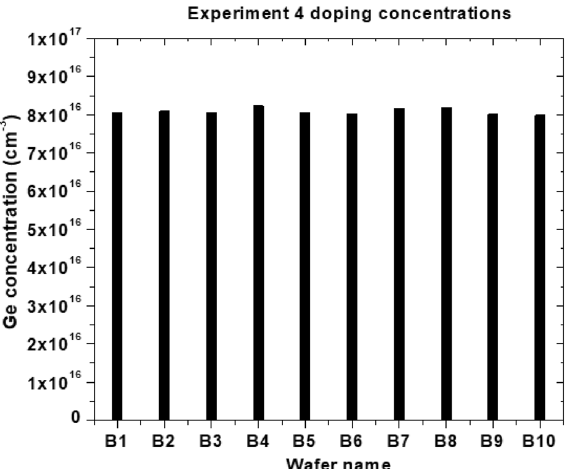
Figure 2. Ge concentrations of the 10 of 1 cm × 1 cm precut samples from B wafer after Experiment #4.